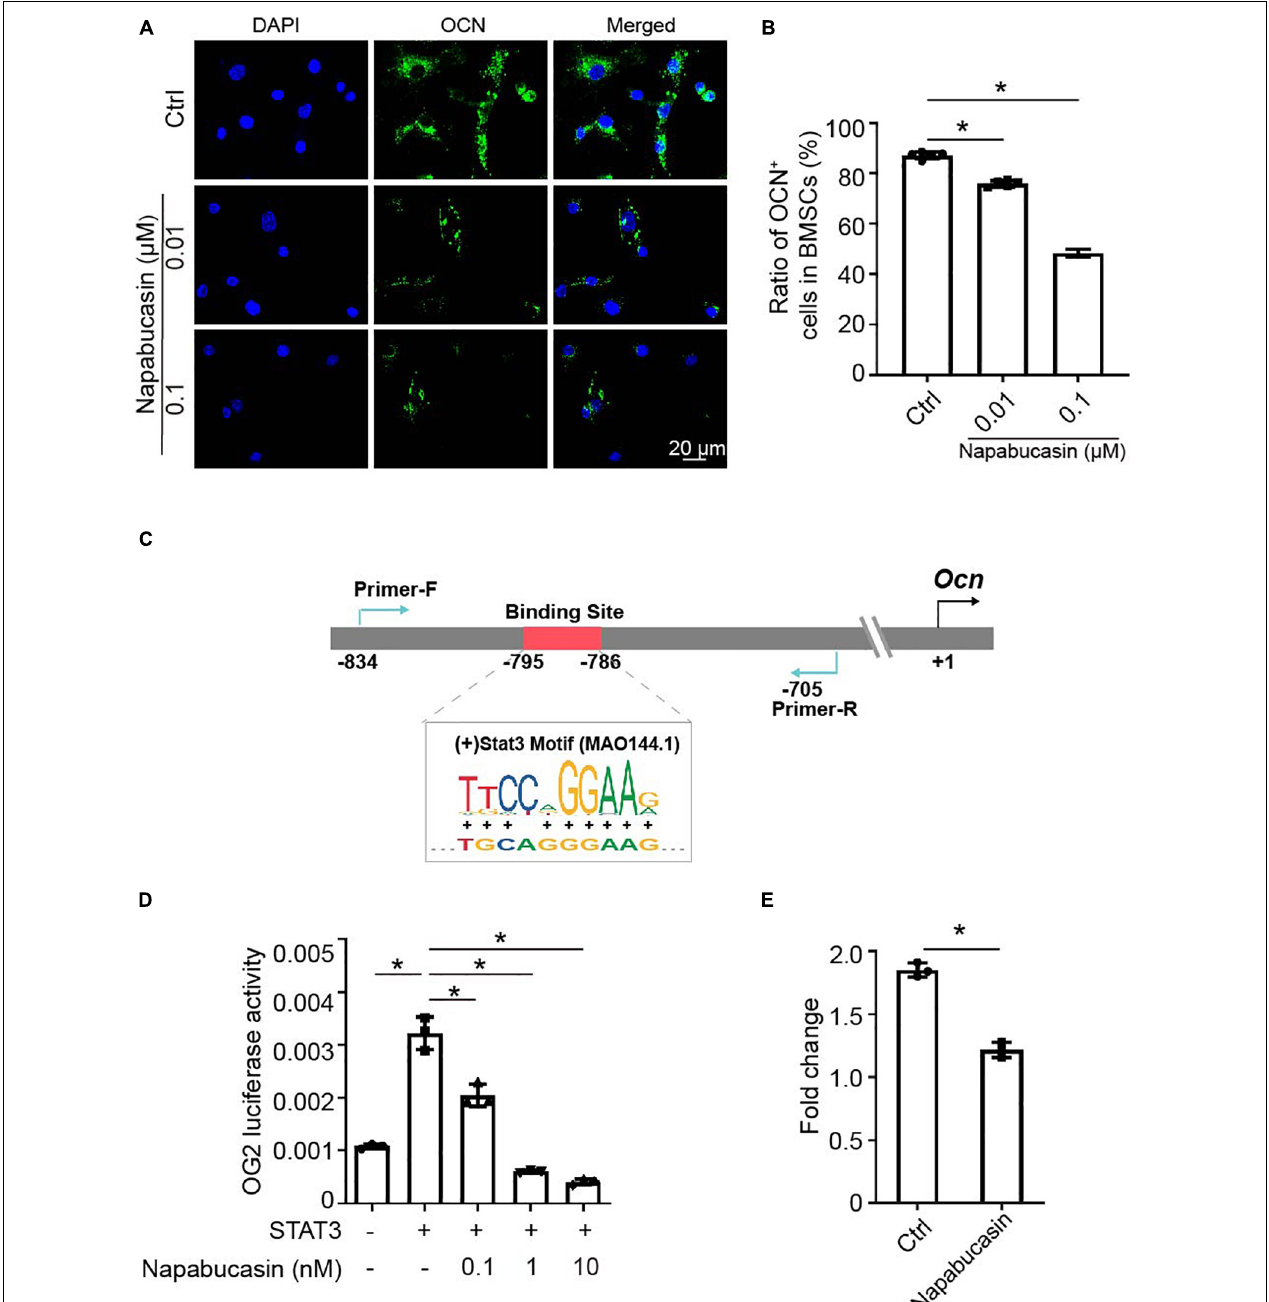
FIGURE 3 | Napabucasin impaired Ocn transcription through STAT3. (A) Representative immunofluorescence image of OCN expression in BMSCs after exposure to Napabucasin. (B) Number of OCN + cells were counted. N = 5. Data are represented as means ± S.D. (C) Illustration of predicted STAT3 binding sites in the Ocn promoter. (D) 293T cells were transfected with STAT3 and Ocn luciferase constructs and treated with DMSO or with different concentrations of Napabucasin. After 48 h, luminescent signals were detected to represent reporter activity. N = 5. Data are represented as means ± S.D. (E) CUT & Tag and subsequent quantitative PCR analysis of STAT3 showing decreased occupancy of the OCN promoter in C3H10 T1/2 cells treated with Napabucasin. Data are shown as fold enrichments to the IgG control. Data are represented as means ± S.D. * P < 0.05.